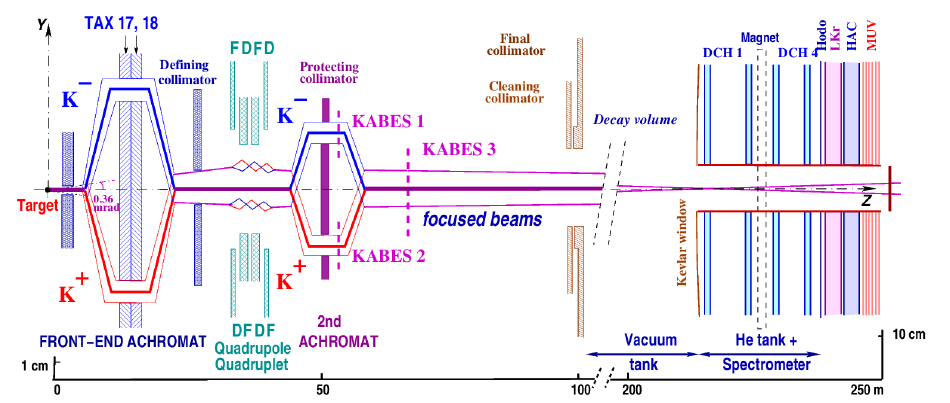
Figure 1. Sketch of the NA48 / 2 beam line, decay volume and detectors